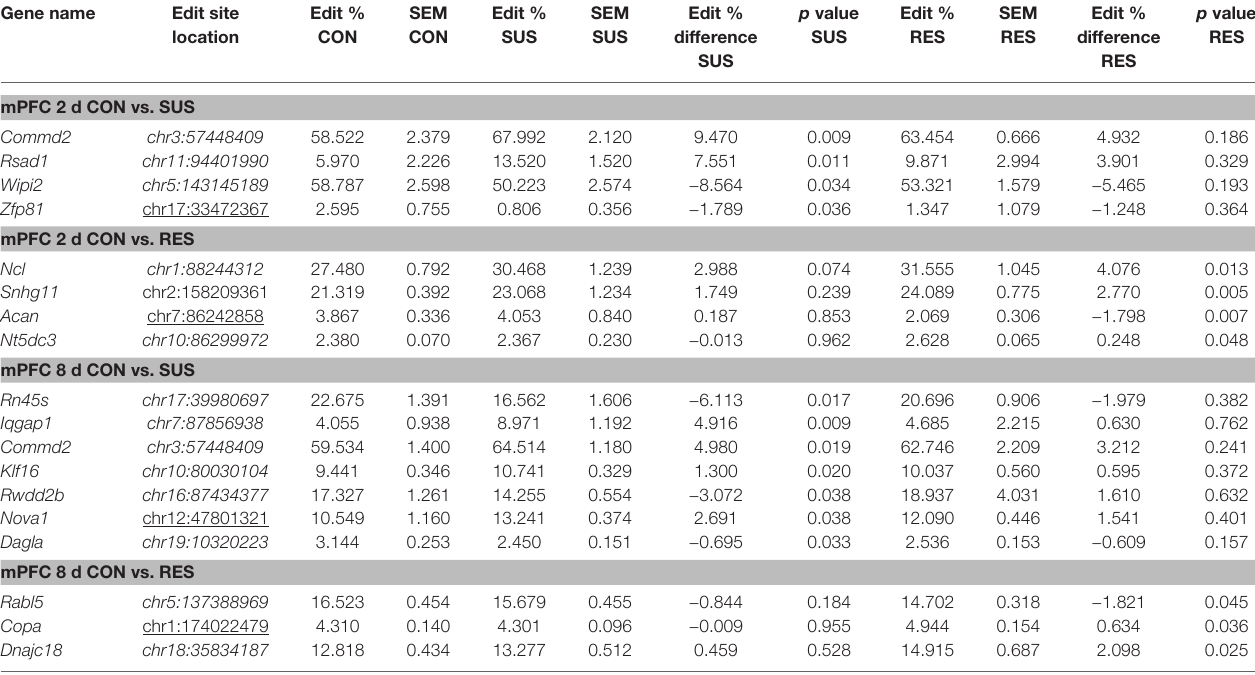
TABLE 2 | Differentially editied loci within the medial prefrontal cortex (mPFC) following